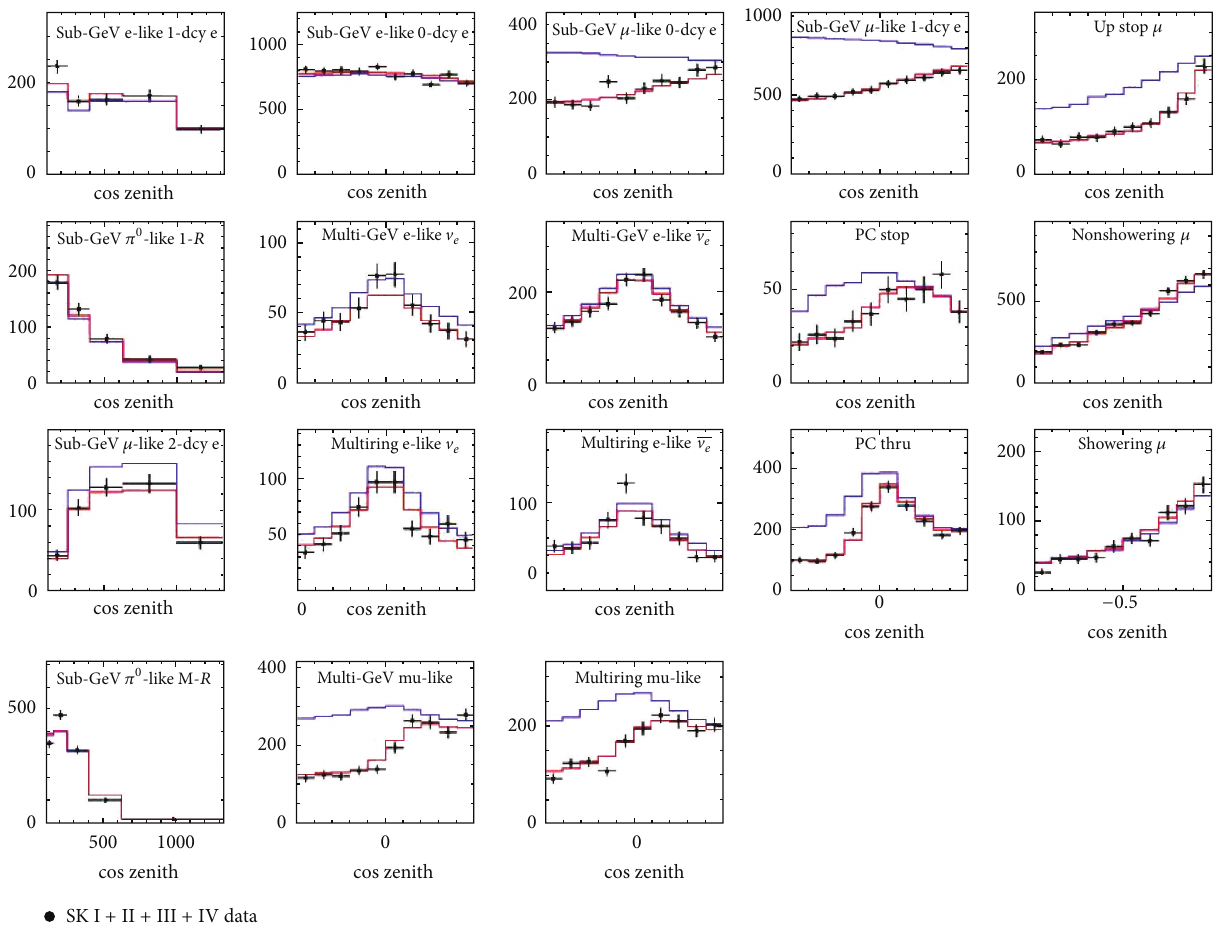
Figure 8: Zenith angle distributions from the SK detector (data from SK I + SK II + SK III)